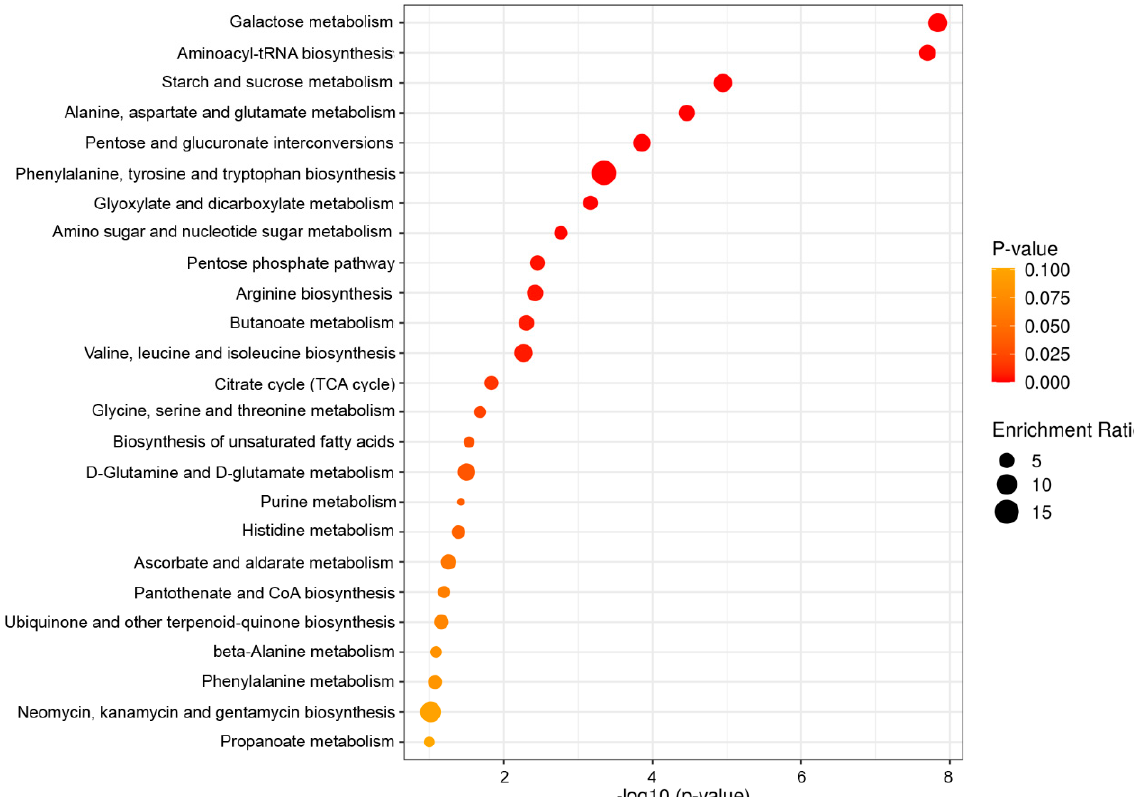
Figure 1. Results of over-representation analysis of the metabolite compounds present in Juniperus communis L. and Taxus baccata L. pollen grains. The red color indicates a significant level ( p < 0.01) while the yellow color indicates a significant level at p = 0.10. The circles represent the number of metabolites involved or enriched in the pathway. The enrichment ratio refers to the ratio of the number of metabolites detected by GC–MS analysis to the total number of metabolites annotated by the pathway. The enrichment overview presents the top 25 metabolic pathways.